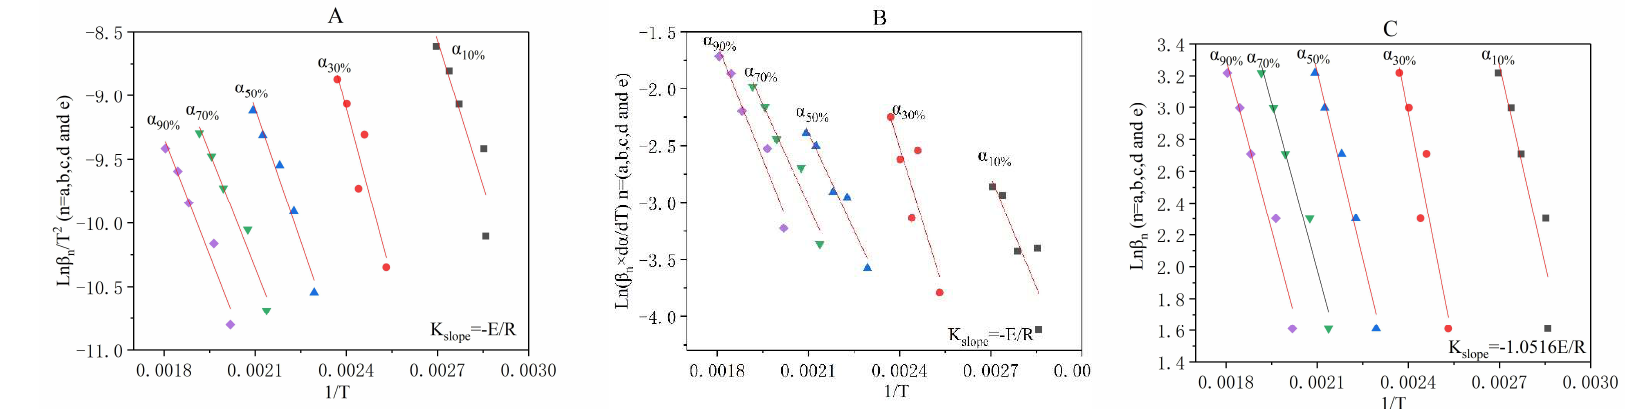
Figure 3. The linear fitting results for Stage 1 under the KAS, Friedman, and FWO methods (( A )—KAS method, ( B )—Friedman method, and ( C )—FWO